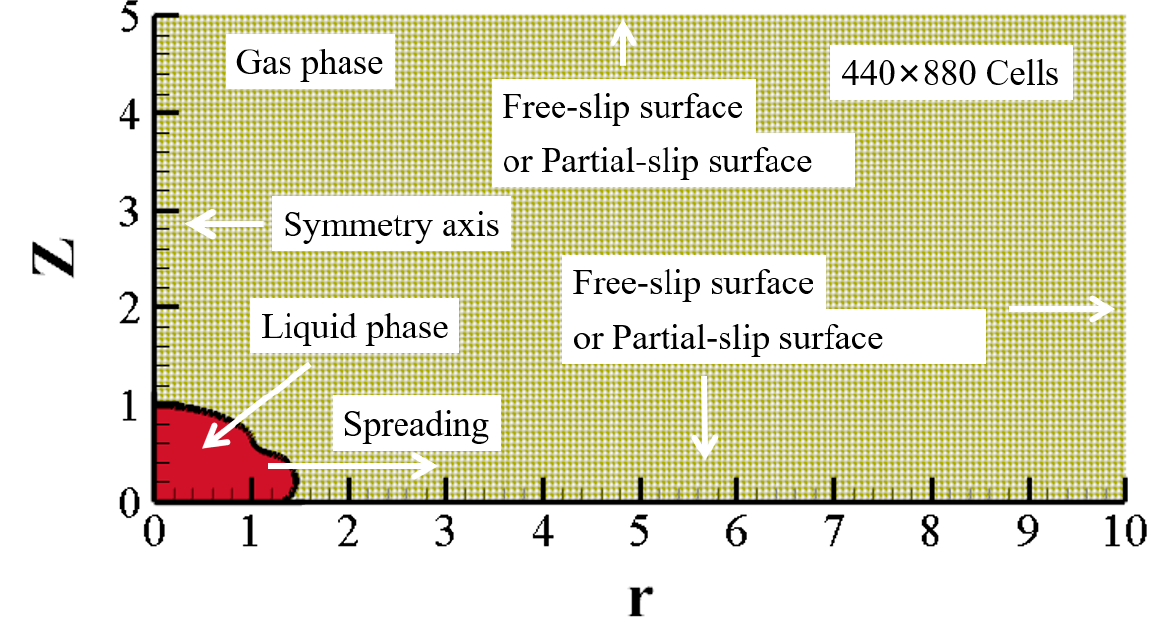
Figure 2. Axisymmetric computational domain with uniform structured grids. Each unit length